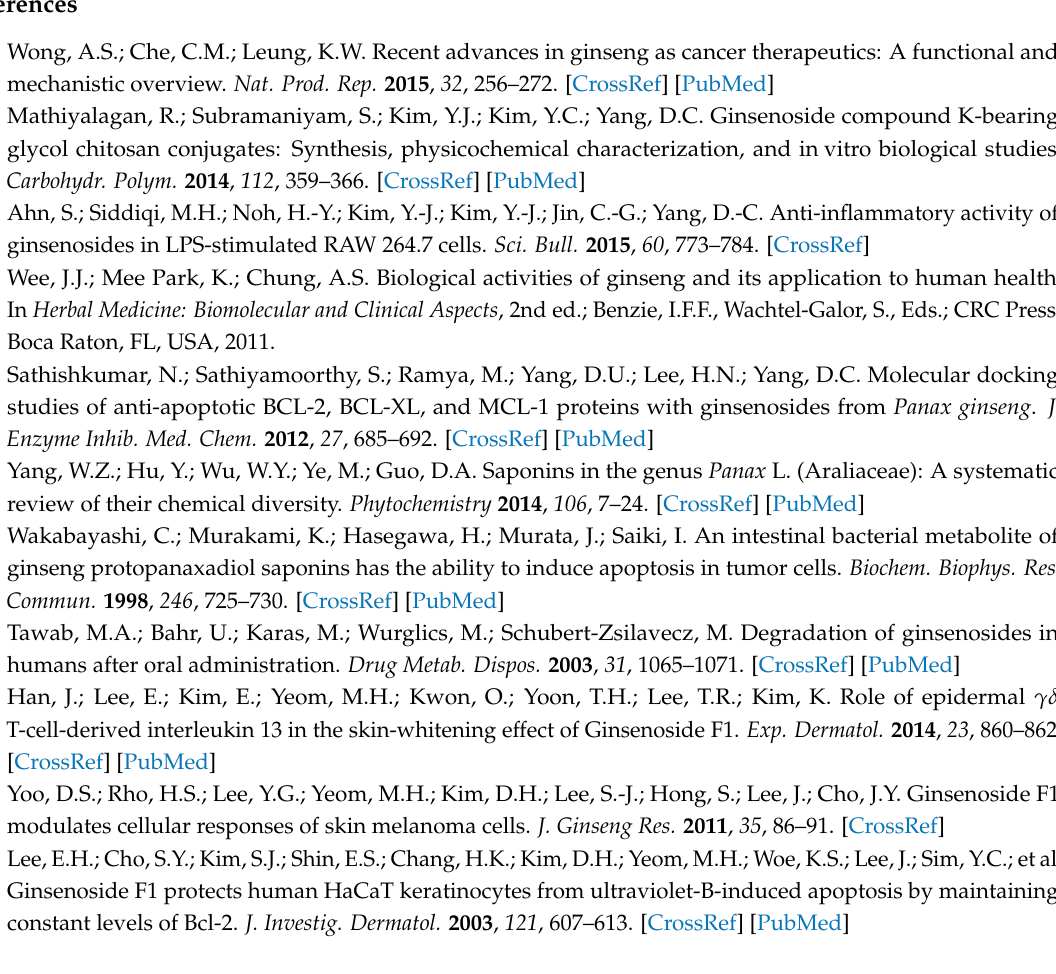
Figure S1: TLC analysis of transglycosylation of minor ginsenosides (Rh2, CK, PPD, Rh1, F1, PPT). S, standard; (i) Each ginsenoside with CGTase only and (ii) Each ginsenoside with CGTase and dextrin, Figure S2. (a). Effect of dextrin on transglycosylation of ginsenoside F1. Toruzyme ® (20 µ L) was incubated with ginsenoside F1 (1 mg) in 1 mL of 20 mM sodium phosphate buffer at 60 ± 1 ◦ C for 2 h, (b). Effect of Toruzyme ® on transglycosylation of ginsenoside F1. Toruzyme ® (5–30 µ L) was incubated with ginsenoside F1 (1 mg) and dextrin (5 mg) in 1 mL of 20 mM sodium phosphate buffer at 60 ± 1 ◦ C for 2 h. The yield was calculated as the increase in product by HPLC, Figure S3: TLC analysis of transglycosylation of ginsenoside F1 with Toruzyme ® and dextrin at different times (min). S, standard of higher molecular weight ginsenosides than F1 in the same protopanaxatriol type ginsenosides; F1+toru (Control 1): Ginsenoside F1 and CGTase Toruzyme enzyme alone; Dextrin+toru (Control 2): Dextrin (sugar donor) and CGTase Toruzyme enzyme alone, Figure S4. (a). Infrared spectrum (FTIR) of novel α -glycosylated ginsenoside F1 (G1–F1), Figure S5. (a). 1 H-NMR spectrum of novel α -glycosylated ginsenoside F1 (G1–F1). (b). 13 C-NMR spectrum of novel α -glycosylated ginsenoside F1 (G1–F1). (c). gHSQC spectrum of novel α -glycosylated ginsenoside F1 (G1–F1). (d). Key gHMBC spectrum of novel α -glycosylated ginsenoside F1